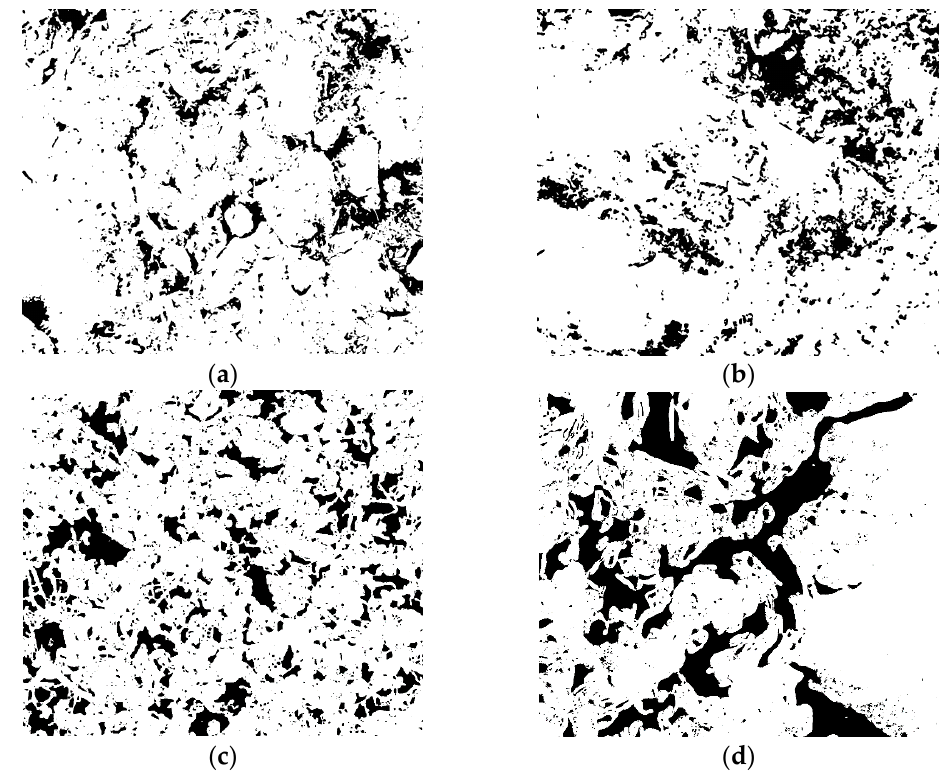
Figure 5. Micromorphology after binarization treatment. ( a ) 0.15 m; ( b ) 0.45 m; ( c ) 0.75 m; ( d ) 1.05 m.